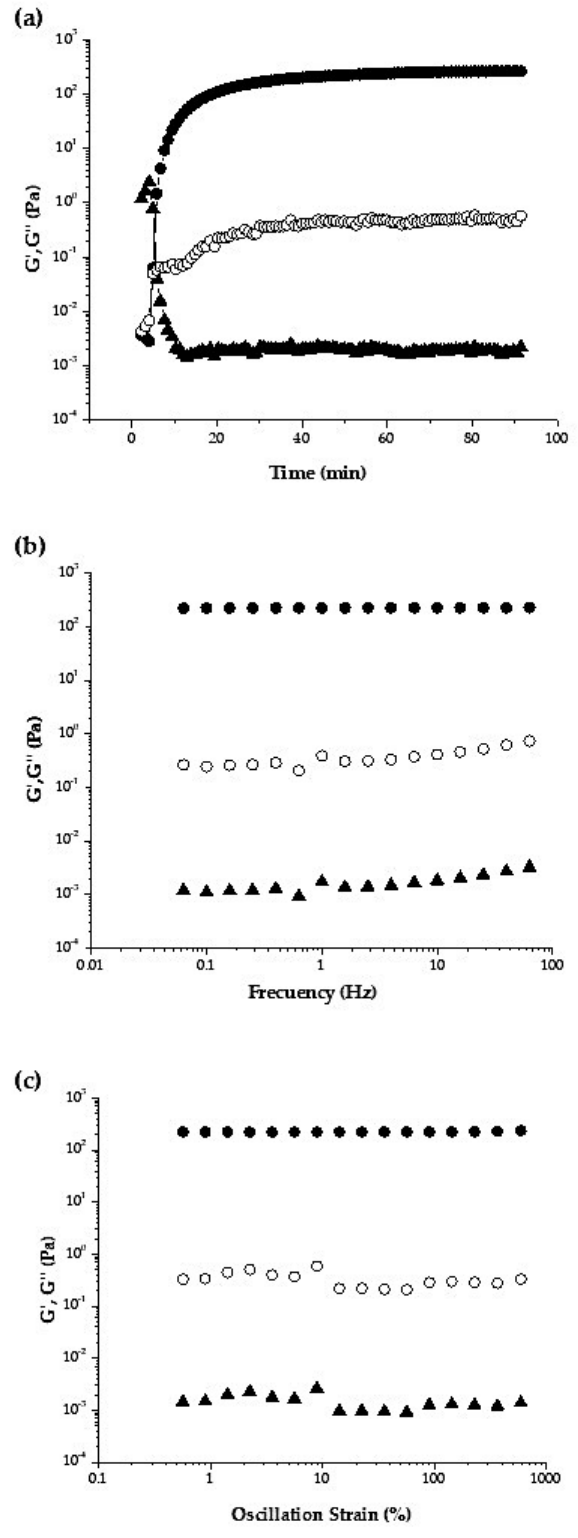
Figure 6. ( a ) Gelation of 1% ( w / v ) dispersion of AX extracted from DDGS during laccase exposure at 0.25 Hz and 5% strain; ( b ) mechanical spectrum of 1% ( w / v ) cured AX gels, measurements at 5% strain; ( c ) Strain sweep of 1% ( w / v ) cured AX gels, measurements at 0.25 Hz. All tests performed at 25 ◦ C. G’ ( • ), G” ( ), tan δ ( (cid:78) (cid:35)